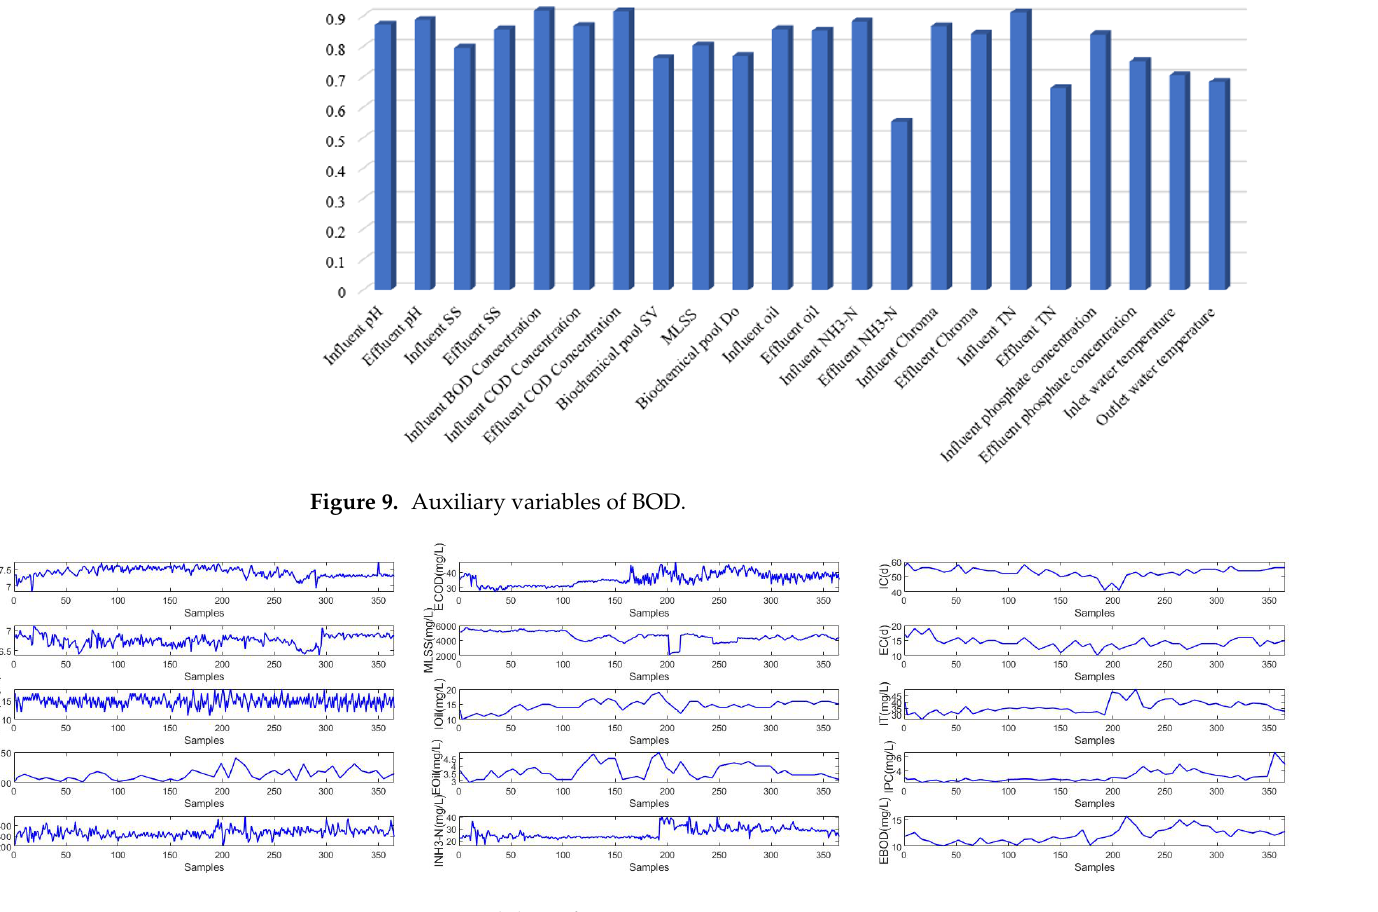
Figure 10. Original data of BOD. Table 5. Data after